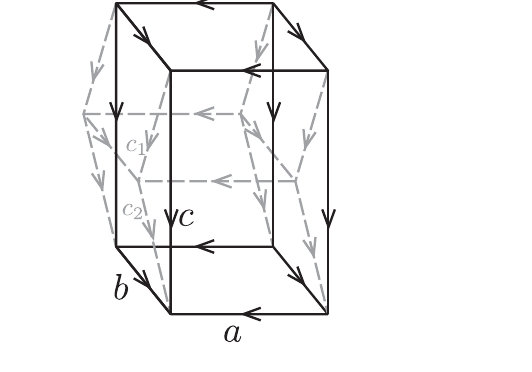
FIG. 8. Evolution from single vertex to two vertices.